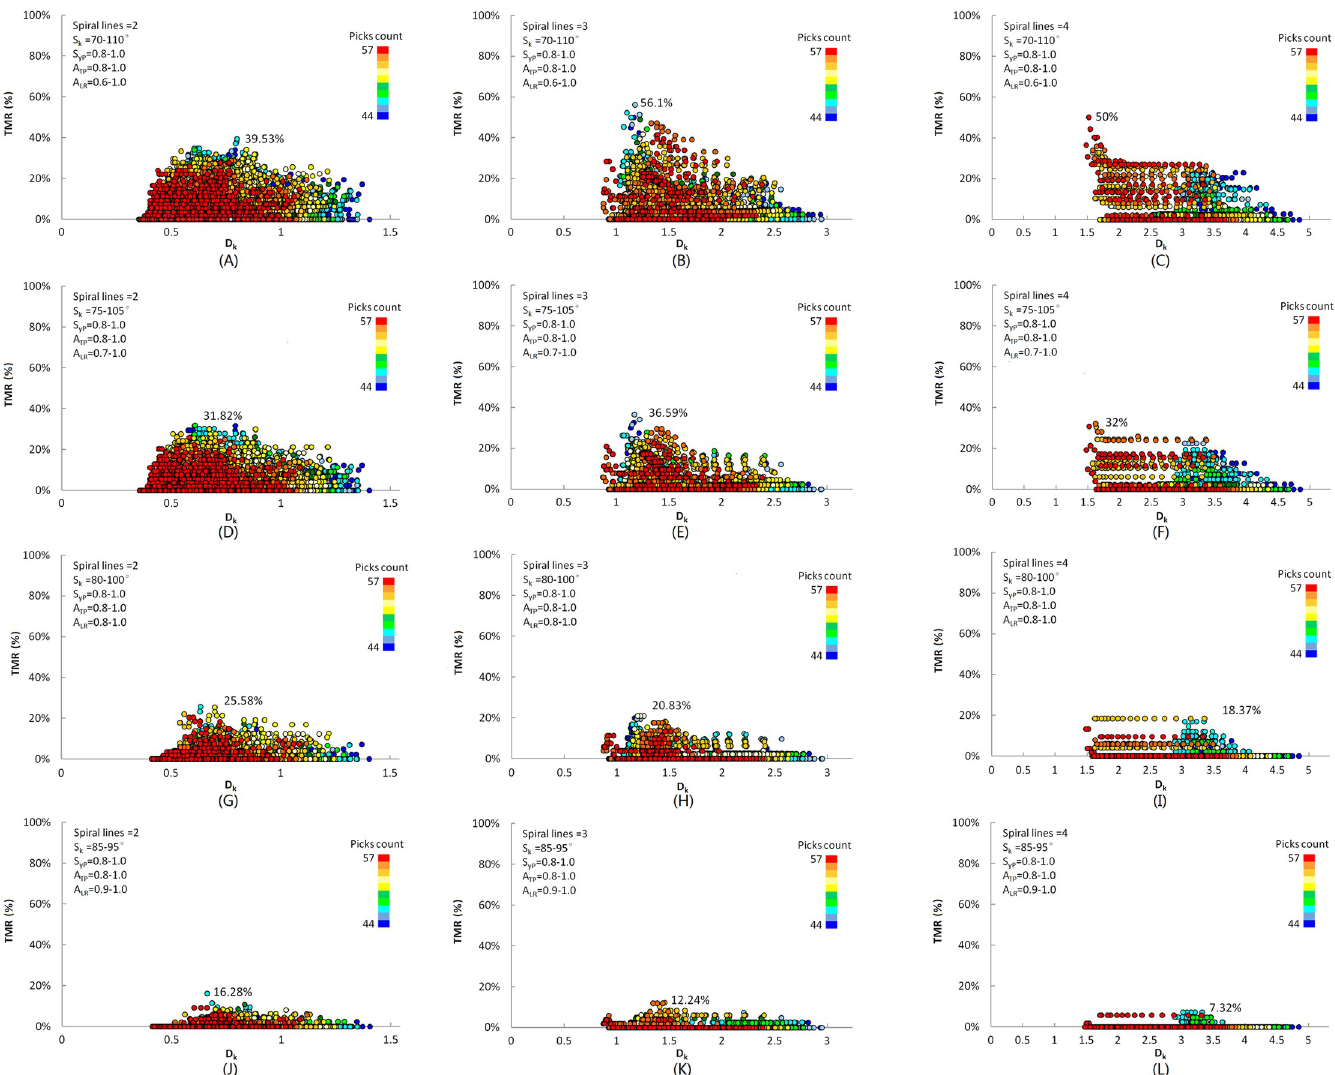
Fig 7. TMR filtering results of cutting head with different helices. (A) 13898 traversal results of 2 helices. (B) 2786 traversal results of 3 helices. (C) 742 traversal results of 4 helices. (D) 11904 traversal results of 2 helices. (E) 1880 traversal results of 3 helices. (F) 512 traversal results of 4 helices. (G) 8100 traversal results of 2 helices. (H) 1038 traversal results of 3 helices. (I) 257 traversal results of 4 helices. (J) 2369 traversal results of 2 helices. (K) 374 traversal results of 3 helices. (L) 66 traversal results of 4